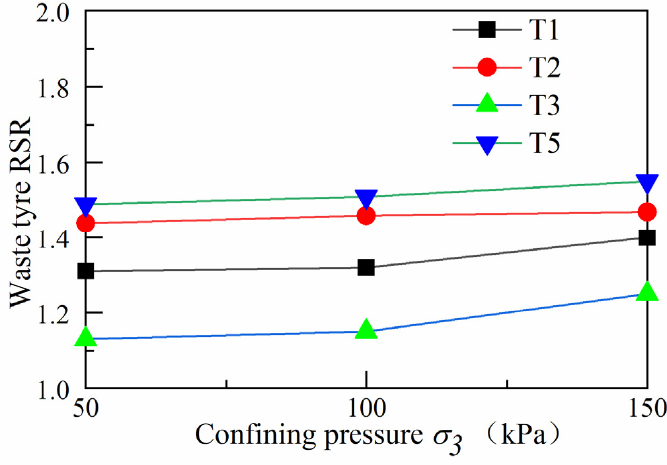
Figure 15. Waste tyre reinforcement strength ratio.